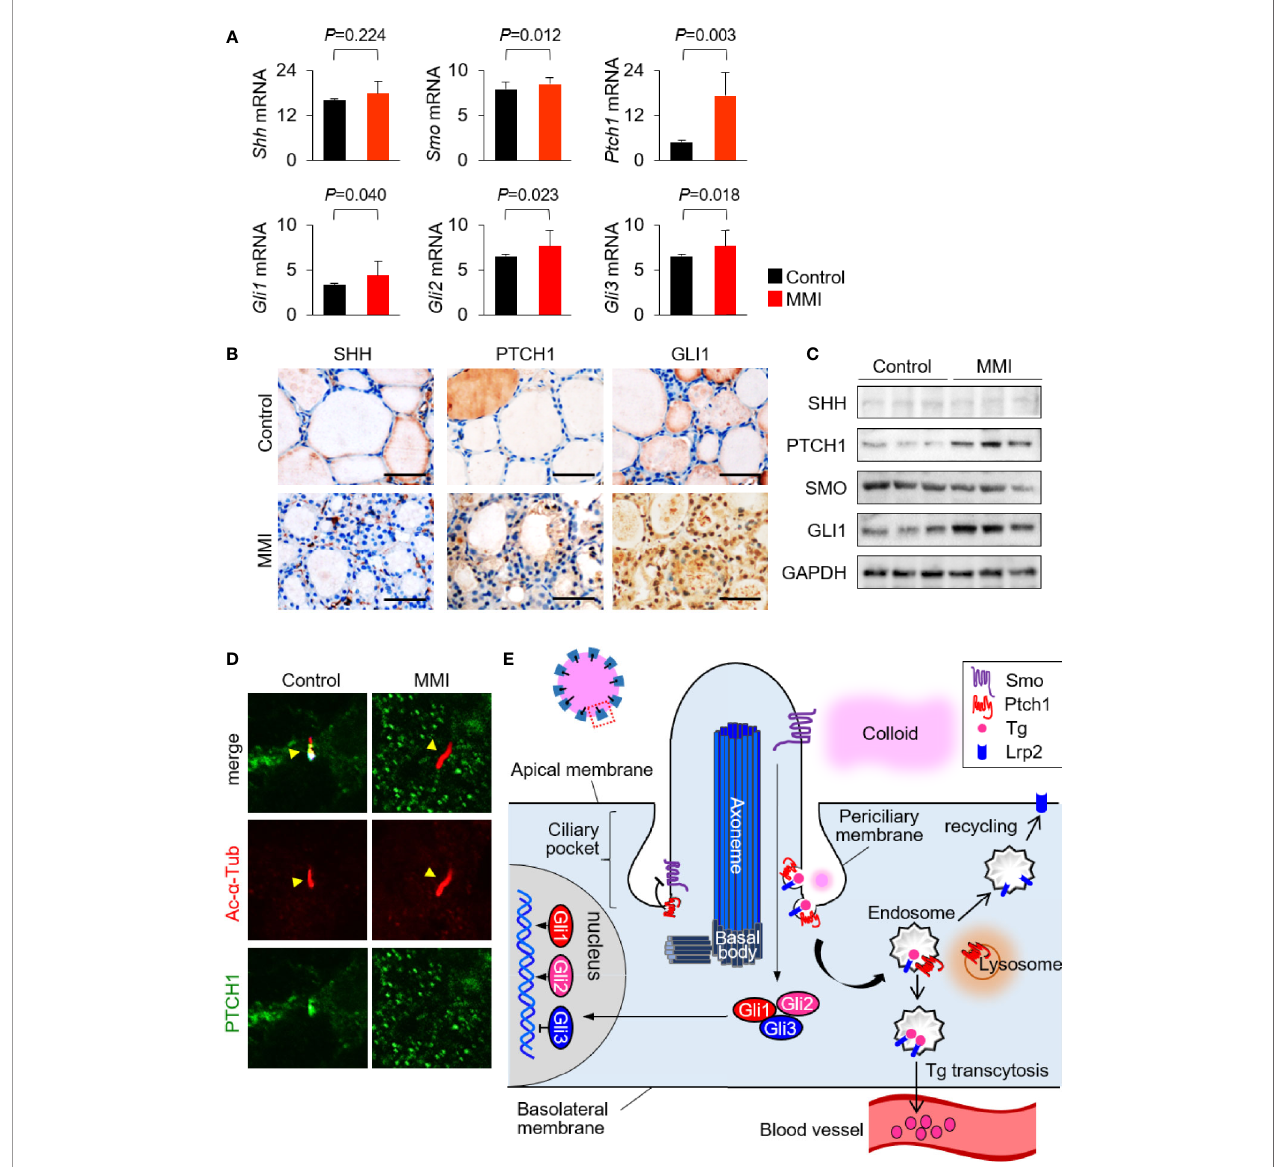
FIGURE 5 | Interaction between LRP2/megalin and SHH in primary cilium of murine thyroid follicles. (A) mRNA levels of Smo , Ptch1 , Gli1 , Gli2 , and Gli3 were higher in the thyroid of MMI-treated mice, which exhibited elevated ciliogenesis, than in the control group. (B) Immunohistochemistry of PTCH1 and GLI1 was consistently upregulated in the thyroid follicles of MMI-treated mice relative to control. SHH was barely detected in the thyroid of MMI-treated and control mice. Scale bar, 25 m m. (C) Immunoblot analysis revealed that PTCH1 and GLI1 levels were higher in MMI-treated mice than in controls. We observed no difference in the expressions of SHH and SMO. Immunoblot data are normalized against GAPDH levels in the same sample. (D) PTCH1 was localized in the primary cilium (arrow head) of thyroid follicular cells in the control group. In MMI-treated mice, loss of PTCH1 from the primary cilium (arrow head) was con fi rmed by immuno fl uorescence staining. (E) Proposed mechanisms for the relationship between receptor-mediated Tg endocytosis and Shh signaling at the primary